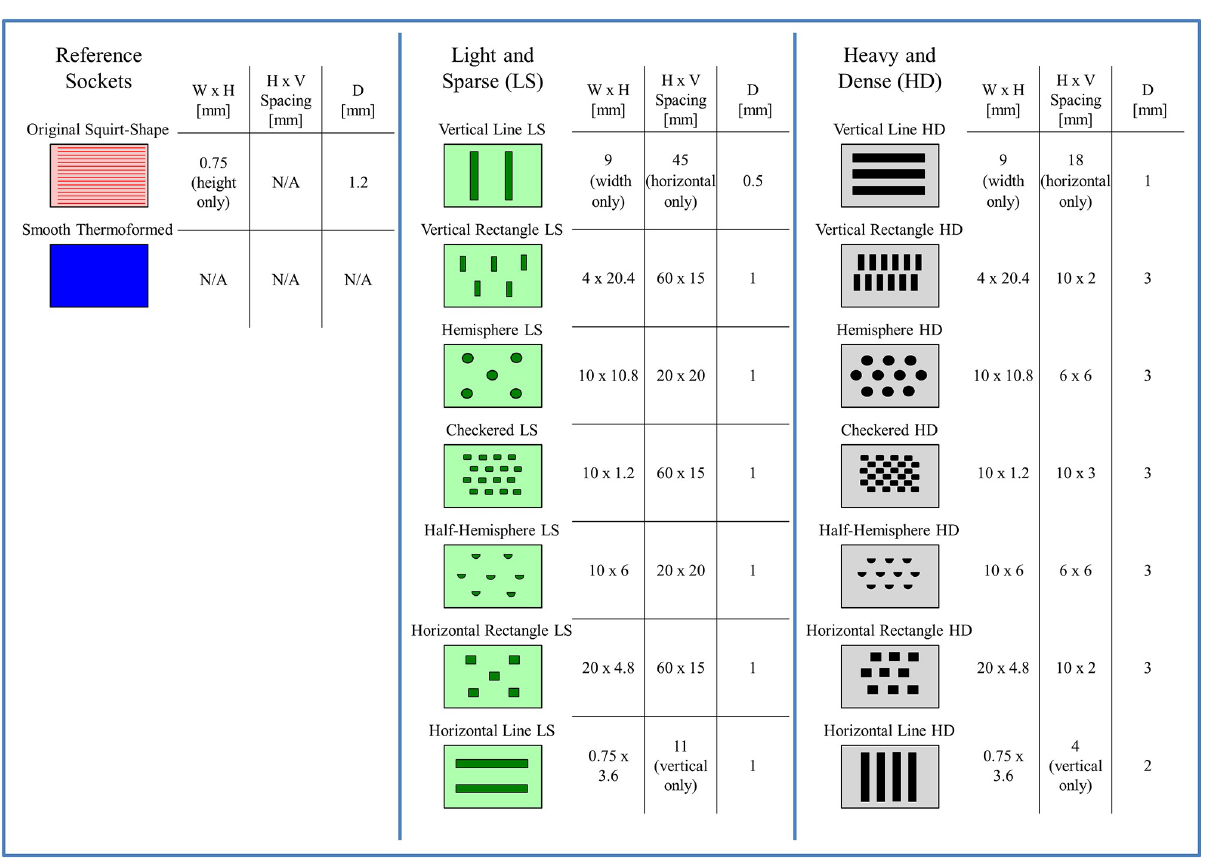
Fig 2. Schematic of novel texture and reference patterns assessed in this study and their respective dimensions. Textures are organized, top left to bottom right, from those with a primarily vertical orientation of texture pattern to those with a primarily horizontal orientation of texture pattern. (W x H–width and height in [mm], H x V spacing–horizontal and vertical spacing in [mm], D–depth in